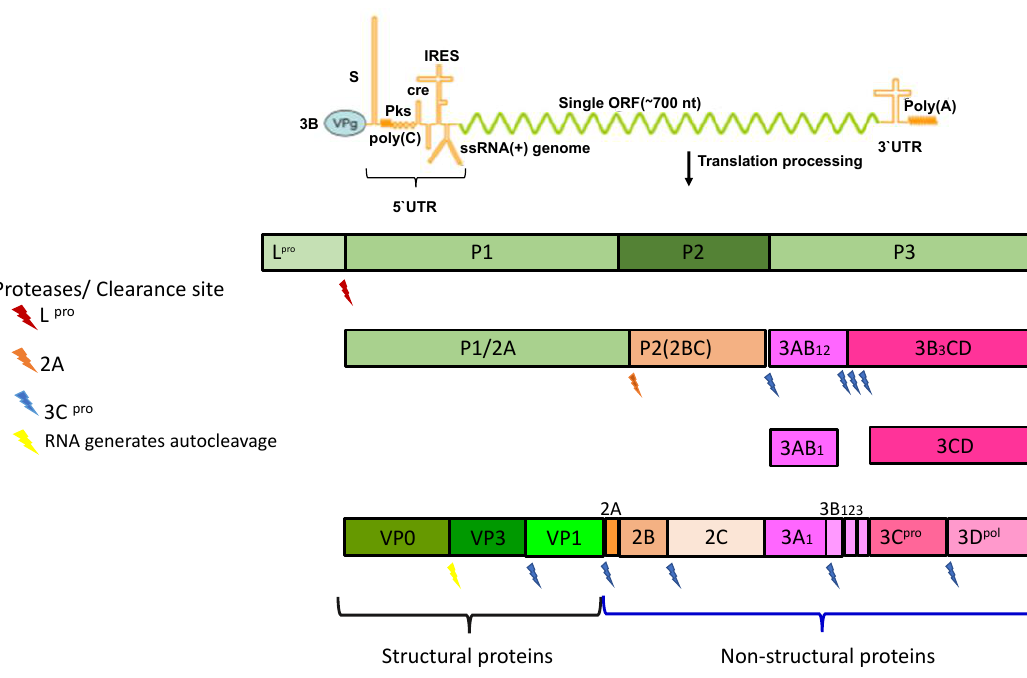
Figure2. DiagramoftheFMDVgenome, viralpolypeptideprocessing, andstructuralandnon-structural Figure 2. Diagram of the FMDV genome, viral polypeptide processing, and structural and non- protein formation. Adapted structural protein formation. Adapted [14,36,42,43].